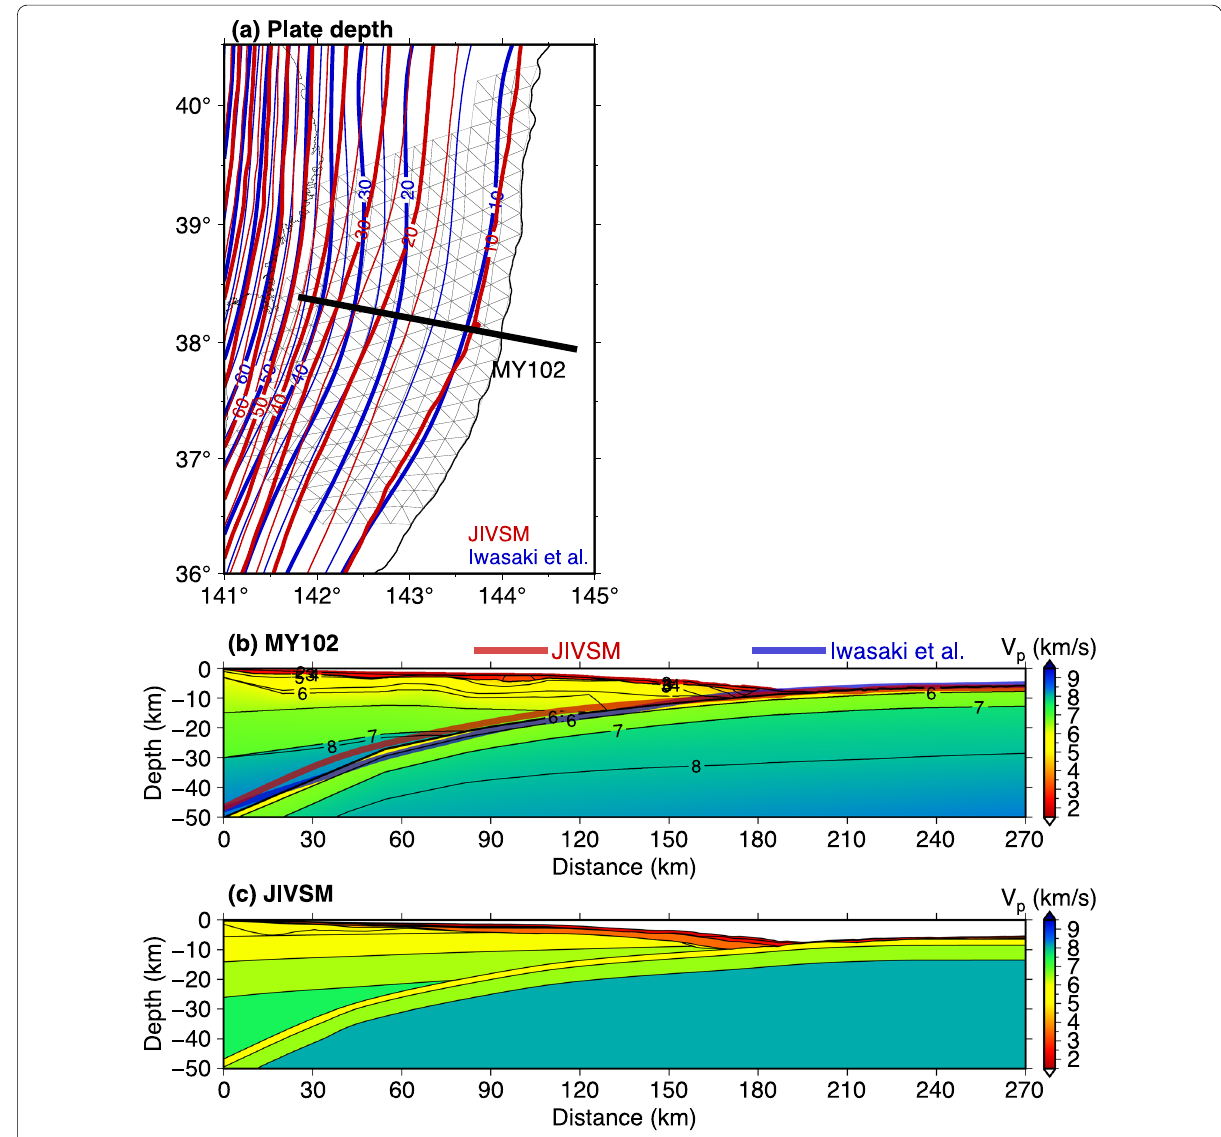
Fig. 12 Comparison of the plate depth and velocity structure of the previous studies. a Comparison of the plate depth of JIVSM (Koketsu et al. 2012, dark red contours) and that of Iwasaki et al. (2015) (dark blue contours). b The vertical profile along the MY102 line (Miura et al. 2005, thick black line in Fig. 10a). Colors indicate the V p structure estimated by Miura et al. (2005). The plate depth contours of both JIVSM and Iwasaki et al. (2015) are also drawn. c The V p structure of JIVSM along the MY102